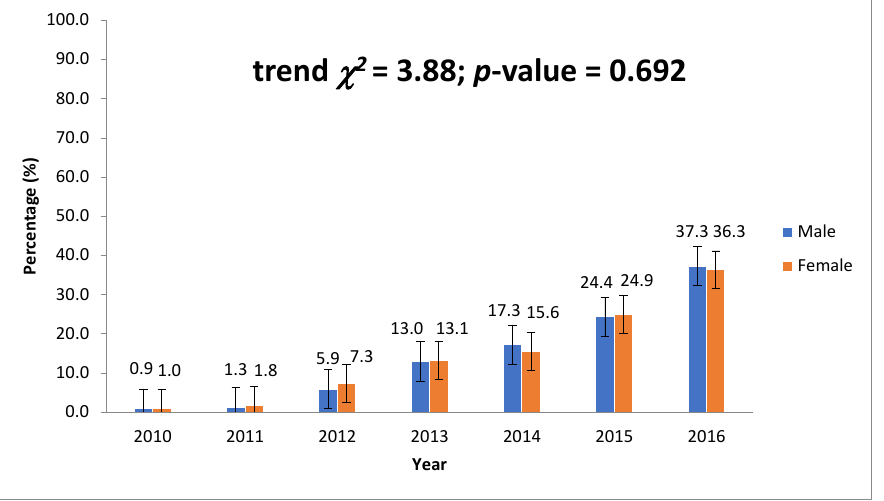
Figure 1. Trend of DR-TB cases by gender per year from 2010 to 2016.